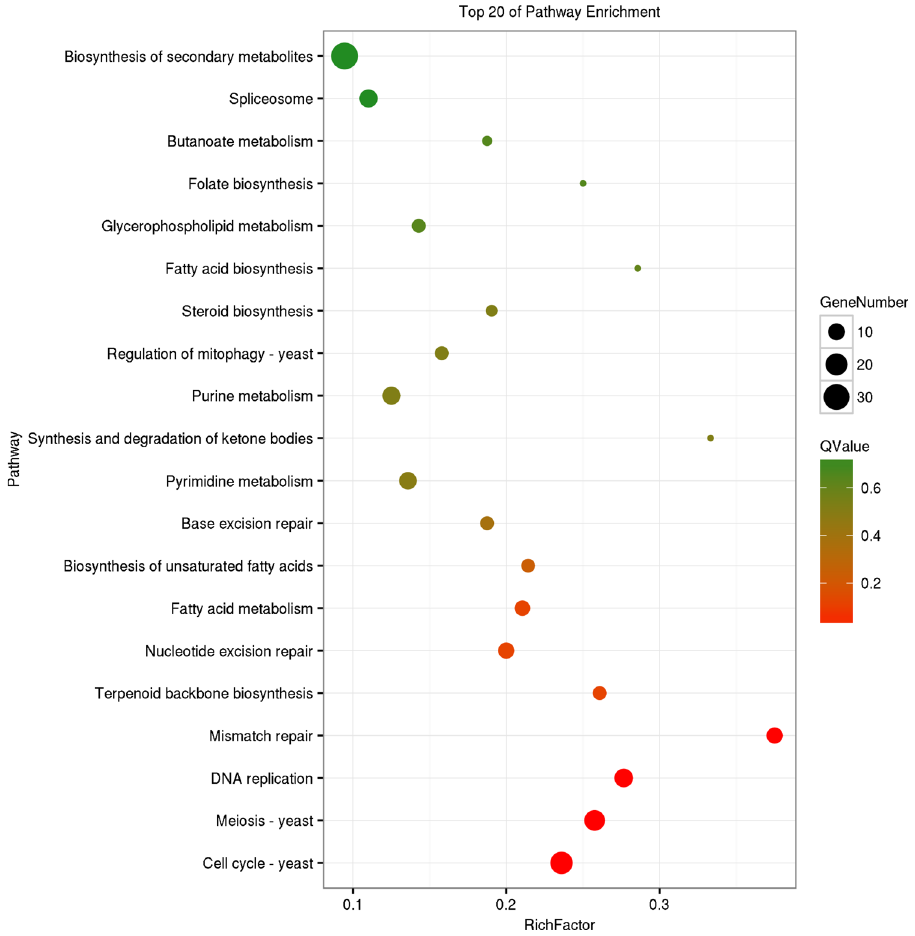
Figure 5. KEGG enrichment diagrams of gene of module bisque4. Vertical axis represents pathway entries, and Rich Factor on the horizontal axis refers to the ratio of the number of genes of DEGs in the pathway to the total number of genes of all genes in the pathway. The higher the Rich Factor value is, the higher enrichment degree is. Size of the circle corresponds to the number of enriched genes, and the larger the circle, the more genes there are. QValue is the p -value after multiple hypothesis test correction, which ranges from 0 to 1, corresponding to the gradual change of red to green. The closer it is to zero, the more red it is, and the more significant the enrichment is. This figure is plotted with the first 20 pathway of QValue of from smallest to